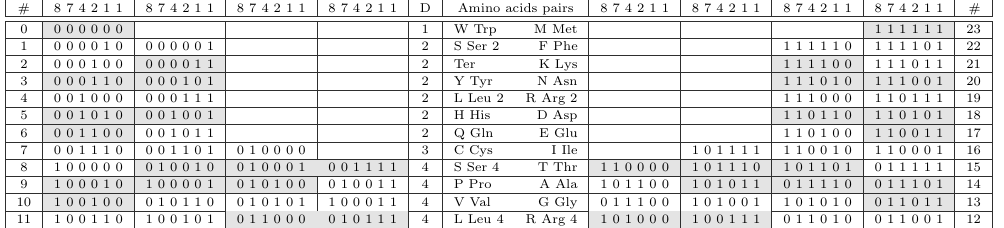
Figure 2 – Representation of the first 24 whole numbers (outer columns) in the non power repre- sentation defined by the positional weights [ 1 1 2 4 7 8 ] (length-6 binary strings, horizontal rows). The degeneracy number (D), number of binary strings that represent the same whole number, and the corresponding amino acids are shown in the centre of the table. The colors indicate the parity of each string (white = odd, gray = even), see section